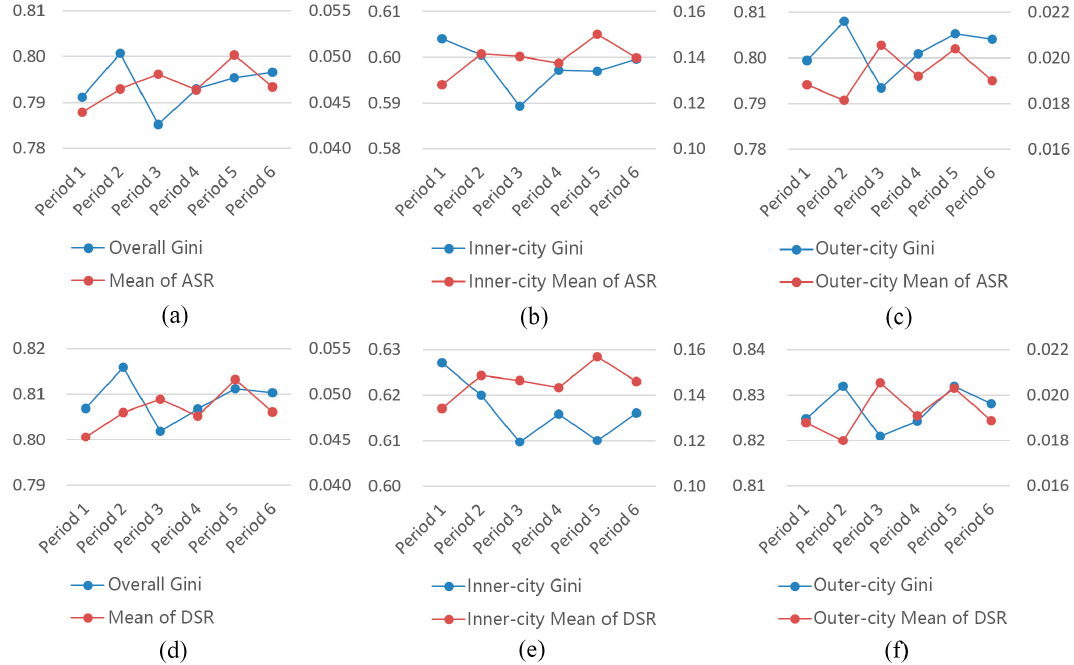
Figure 4. The changes of the Gini coefficient and the changes of the mean of service rate on weekends during the subsidy war. Specifically, they are the overall changes of the Gini coefficient and mean of ASR ( a ), the changes of the inner-city Gini coefficient and the inner-city mean of ASR ( b ), the changes of the outer-city Gini coefficient and the outer-city mean of ASR ( c ), the overall changes of the Gini coefficient and the mean of DSR ( d ), the changes of the inner-city Gini coefficient and the inner-city mean of DSR ( e ), and the changes of the outer-city Gini coefficient and the outer-city mean of DSR ( f ).